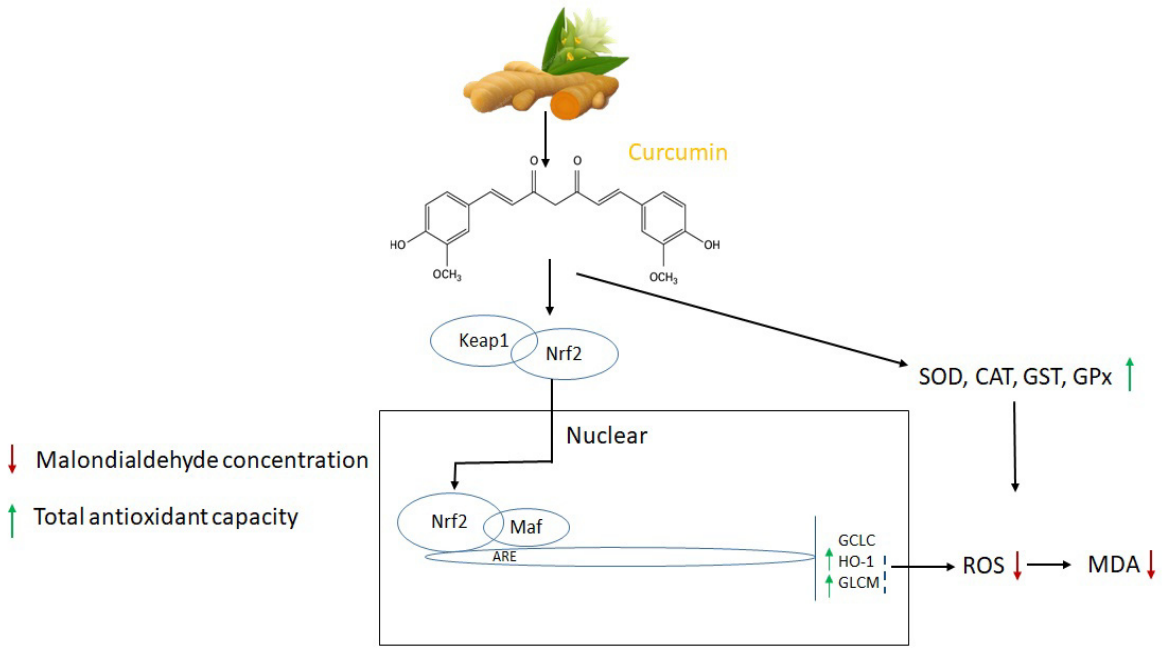
Figure 1. Molecular targets and antioxidant mechanism of curcumin. The activities of superoxide dismutases ( SOD ), catalase (CAT), reactive oxygen species (ROS), malondialdehyde (MDA), glutathione S-transferases (GST), and glutathione peroxidase ( GPx ) adapted from [39,40,44,45].